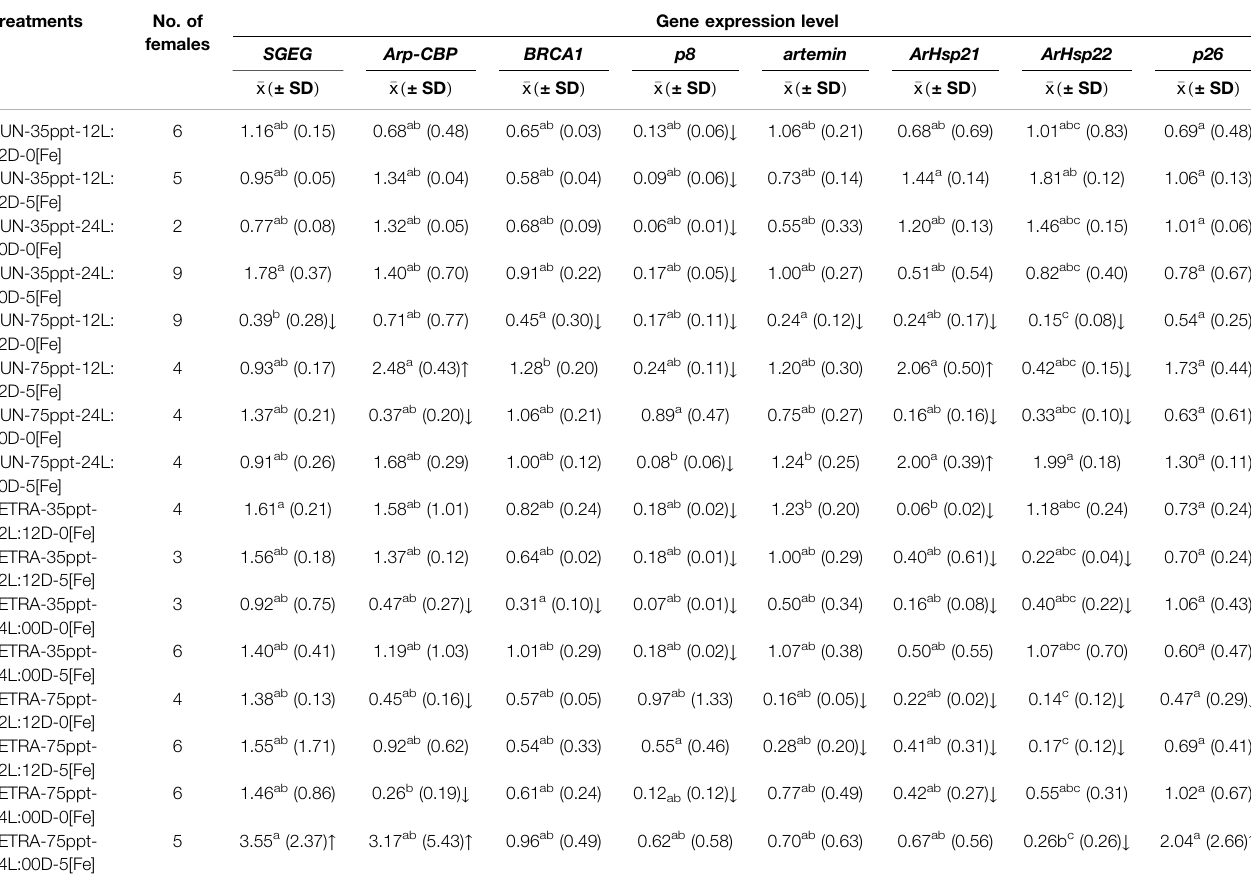
TABLE 7 | Gene expression level in the San Francisco Bay population. Treatments No. of